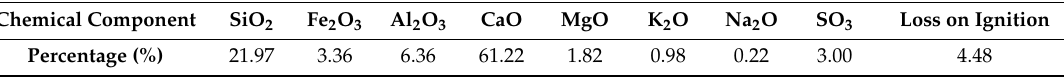
Table 1. Chemical components and percentage of cement.